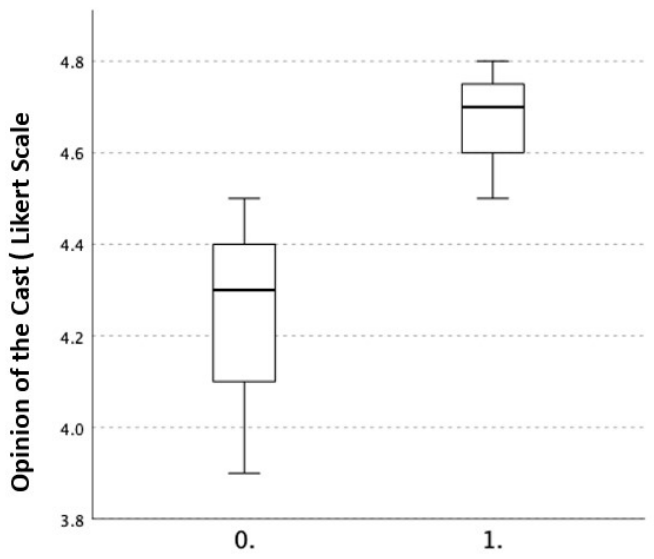
Figure 6. General acceptance of the cast: 0 = children; 1 = parents. Difference not statistically signif- icant.